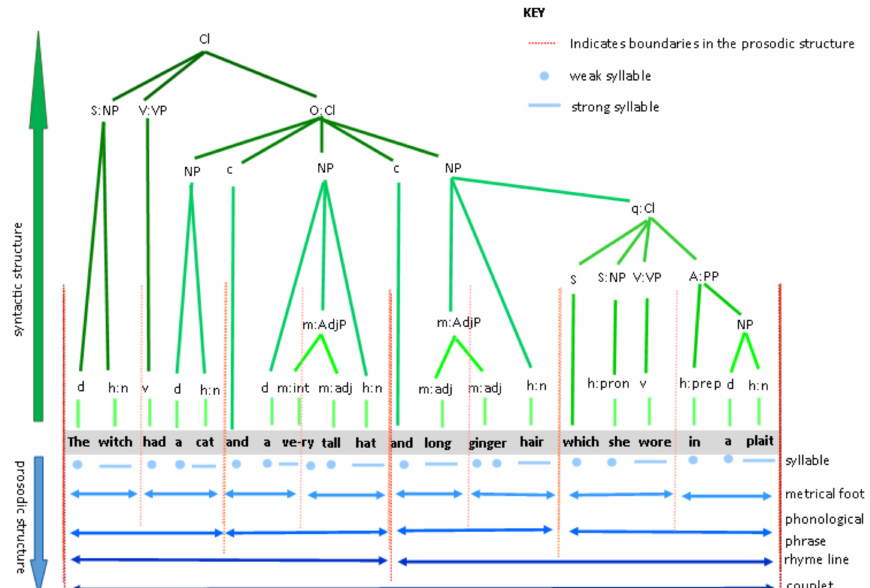
Figure 1. A diagram to illustrate the syntactic and prosodic structure of a line from Room on the